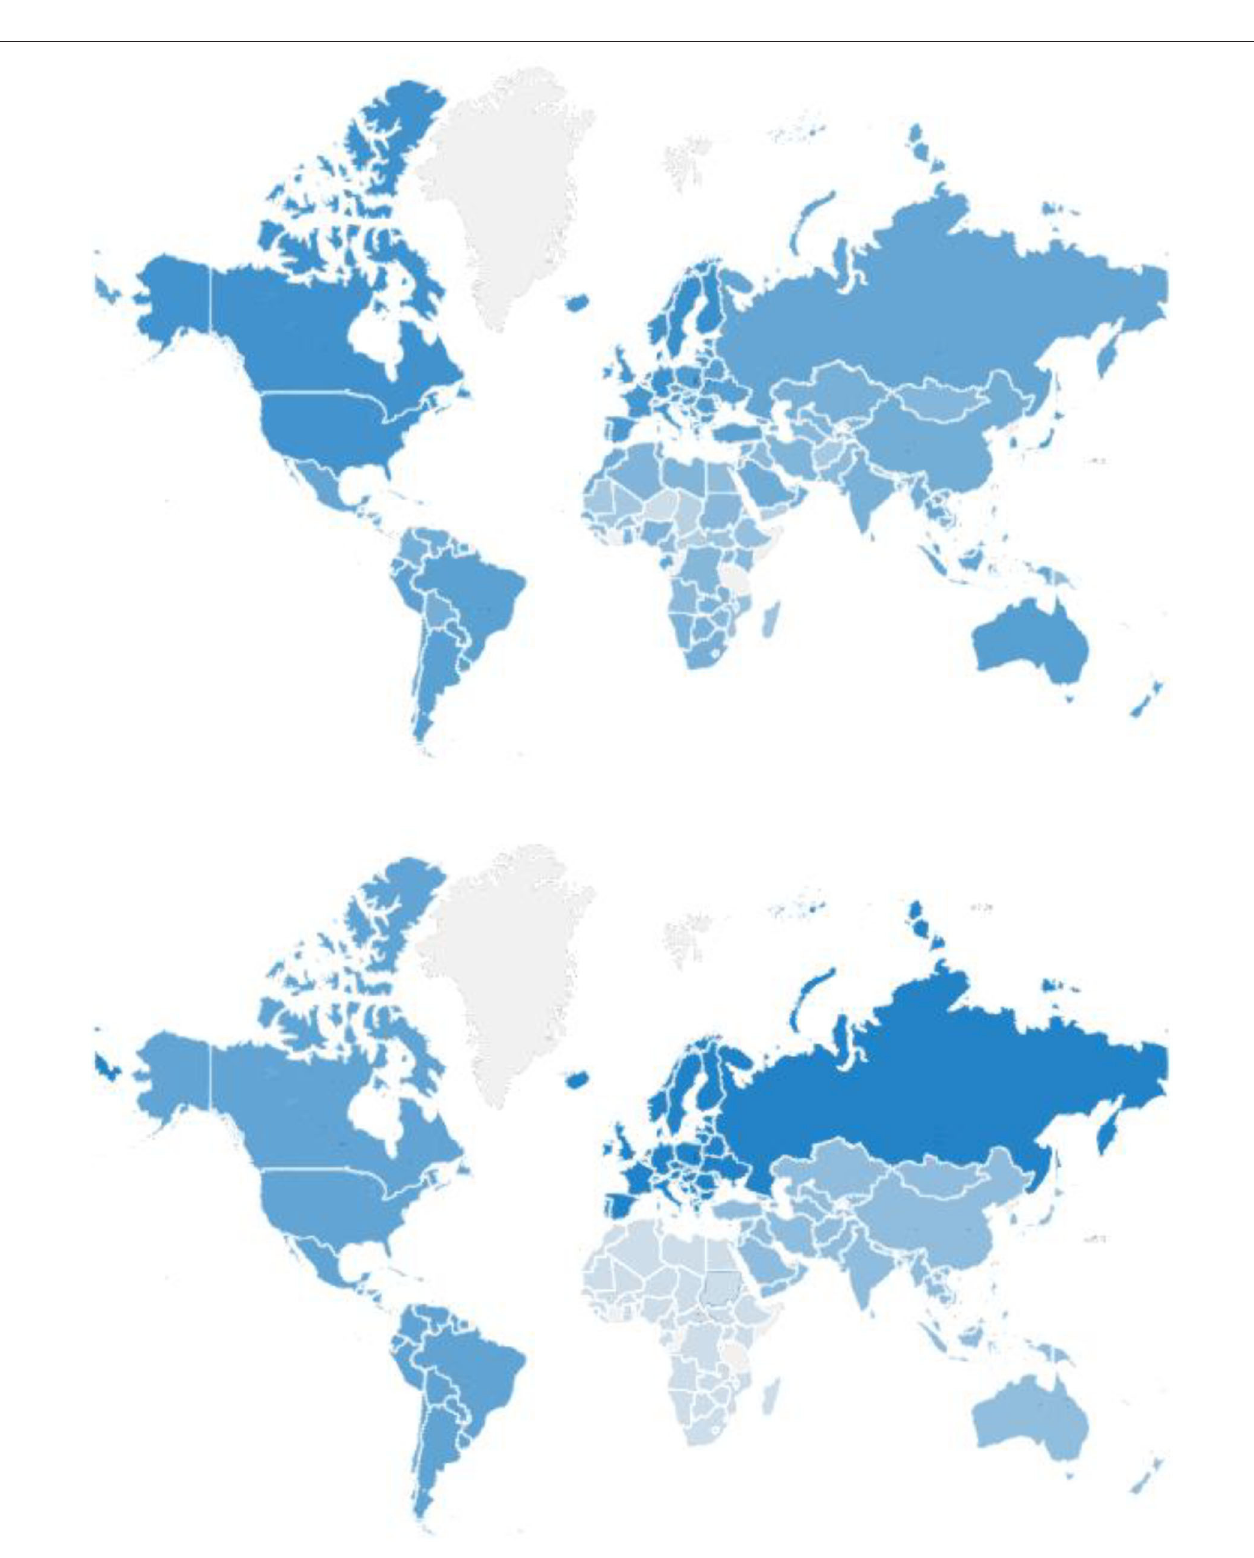
FIGURE 2 | SD score for each country (upper) and continent (lower). The darker the blue, the higher the mean SD score of the country (upper) or the continent (lower).